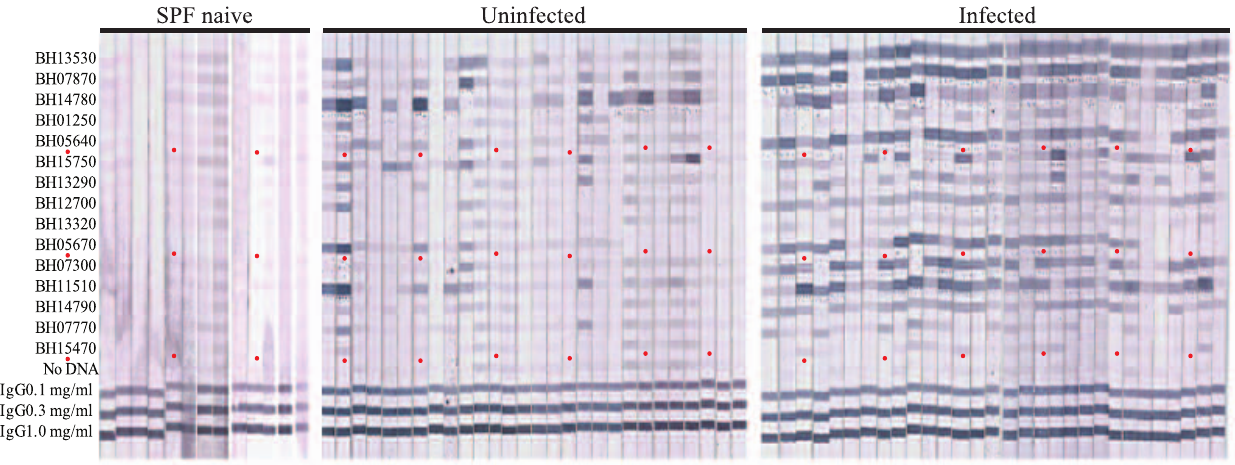
Figure 5. Immunostrips probing. Fifteen serodiagnostic antigens were printed onto nitrocellulose paper in adjacent stripes using a BioDot jet dispenser as described in Materials and Methods. Strips were probed with infected and uninfected sera diluted 1/200 followed by alkaline phosphatase conjugated secondary antibody and enzyme substrate. Weak reactivity in uninfected controls can be distinguished from the strong reactivity in the infected group. A red dot under the 5 th , 10 th , and 15 th antigen is indicated as a guide marker.